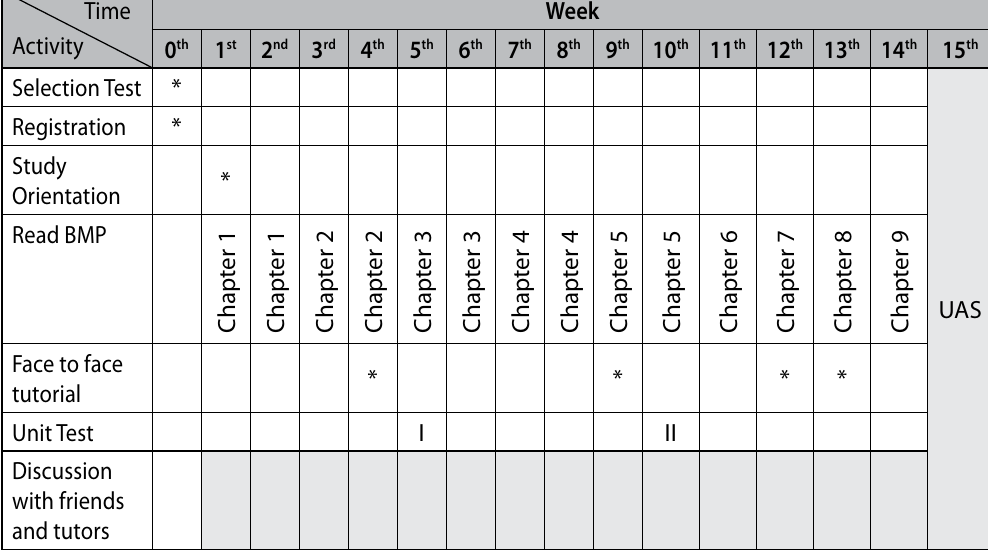
Table 1 A learning plan for students by